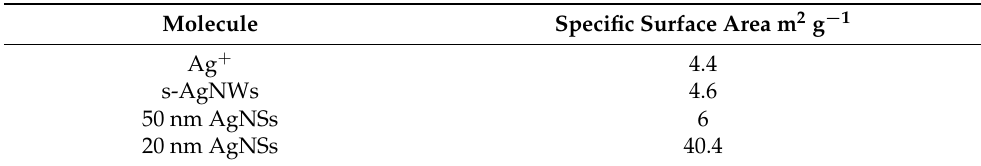
Table 4. Specific surface area of the particles formed from different molecules which form independent variables for the WGAN